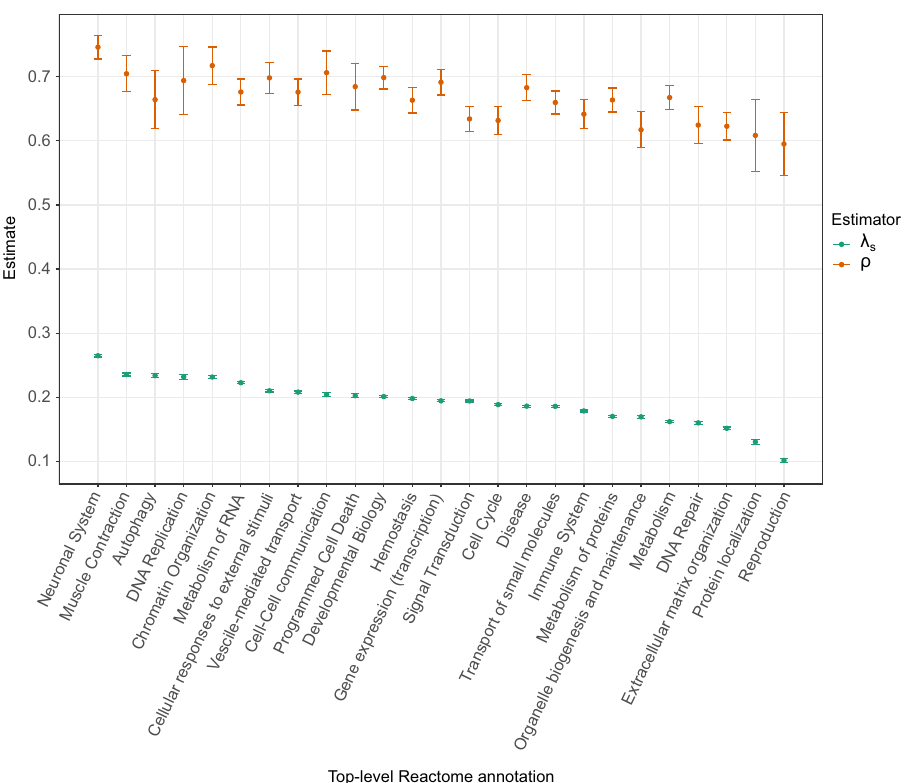
Fig. 2 Measures of purifying selection in protein-coding genes by biological pathway. Genes were assigned coarse-grained functional categories using the top-level annotation from the Reactome pathway database 31 . An estimates for each category is shown for both ExtRaINSIGHT ( λ s ; teal) and INSIGHT ( ρ ; orange). Error bars are centered at the MLE and indicate one standard error in each direction (see “ Methods ” ). Total number of genes: n = 19,256 (ranging from 125 to 2707 per selected sites experiencing ultraselection — was also highest for “ Neuronal System ” genes (at 0.36) and lowest for “ Reproduction ” genes (at 0.18). An analysis of genes exhibiting tissue-speci fi c expression produced similar results, with several brain tissues exhibiting the most ultraselection and vagina exhibiting the least (Supplementary Fig. 7).